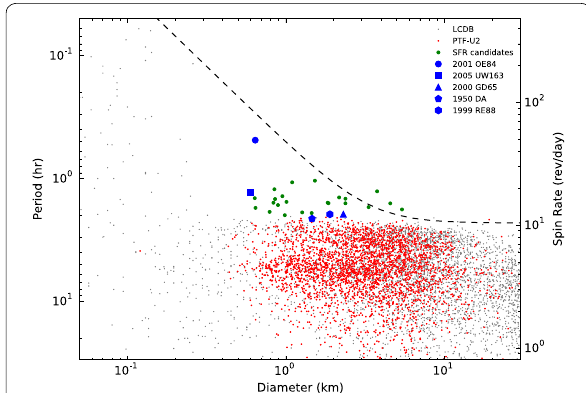
Fig. 3 Asteroid rotation period vs. diameter. The red and gray filled cir- 2 , respectively. The cles are the PTF‑U2s and the LCDB objects of U ≥ larger blue filled symbols are the five known SFRs. The green filled circles are the 23 SFR candidates. The dashed line is the predicted spin barrier k r 1 / 2 adopted from Holsapple et al. (2007), where cohesion is κ − ¯ = 2 25 7 dynes cm − 3 / 2 . Note that the uncertainty in diameter and k = × 20% , which includes the uncertainty in estimation using Eq. (1) is ∼ the absolute magnitude H . The uncertainty in the rotation period is smaller than the symbol size. This figure is reproduced from Chang et al. (2015, 2016)